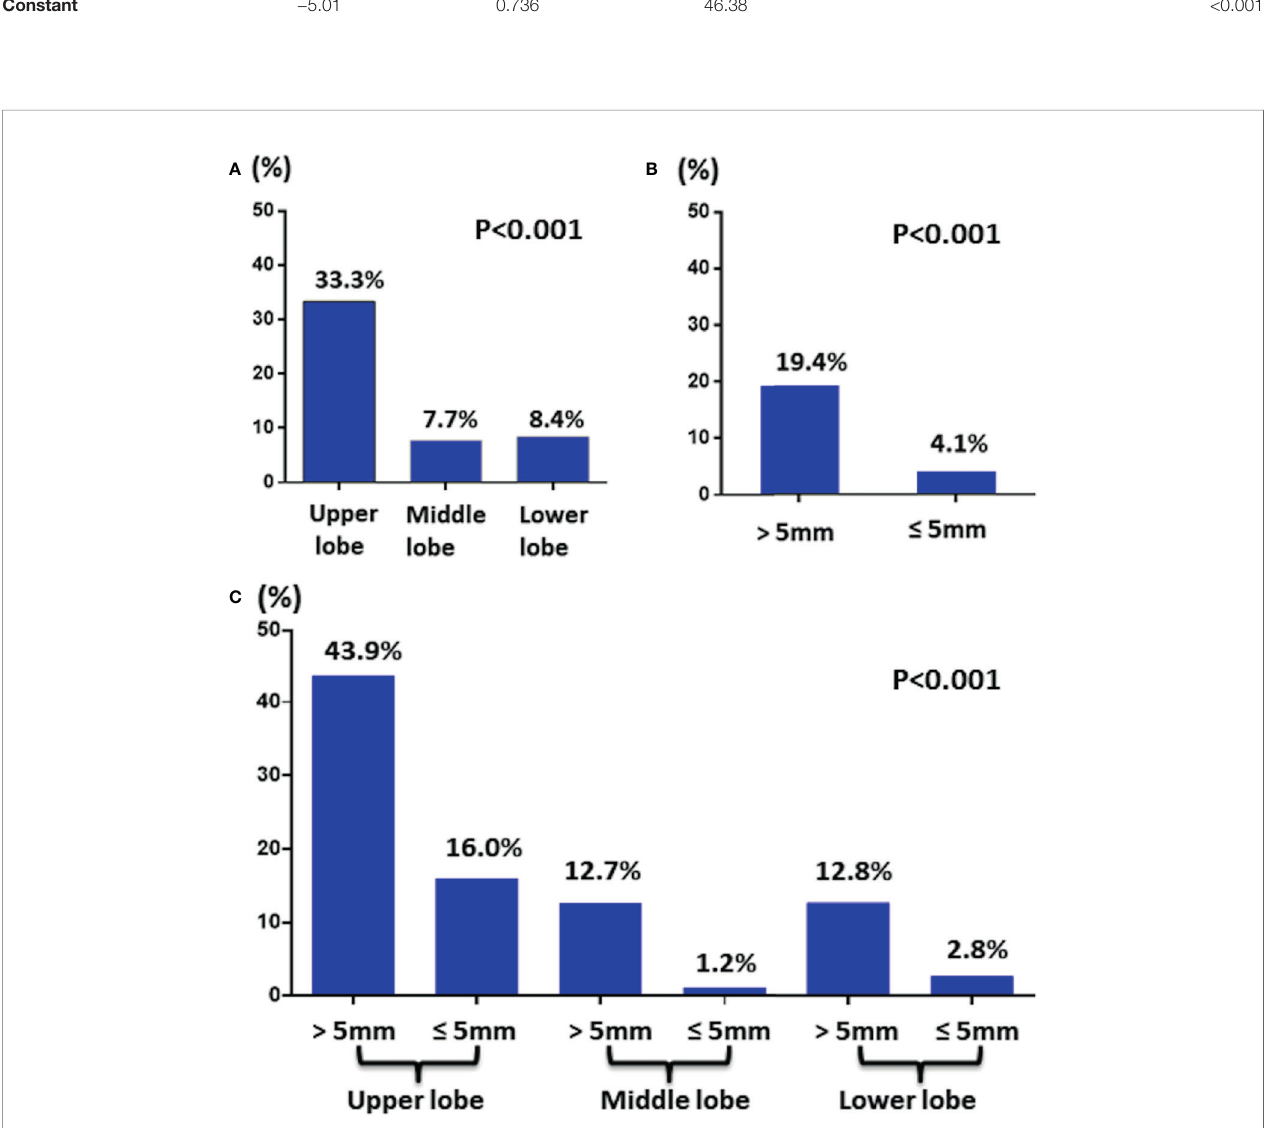
FIGURE 2 | (A) The incidence of lateral LNM in T1a PTC by tumor location. (B) The incidence of lateral LNM in T1a PTC by tumor size. (C) The incidence of lateral LNM in T1a PTC by tumor location and size.